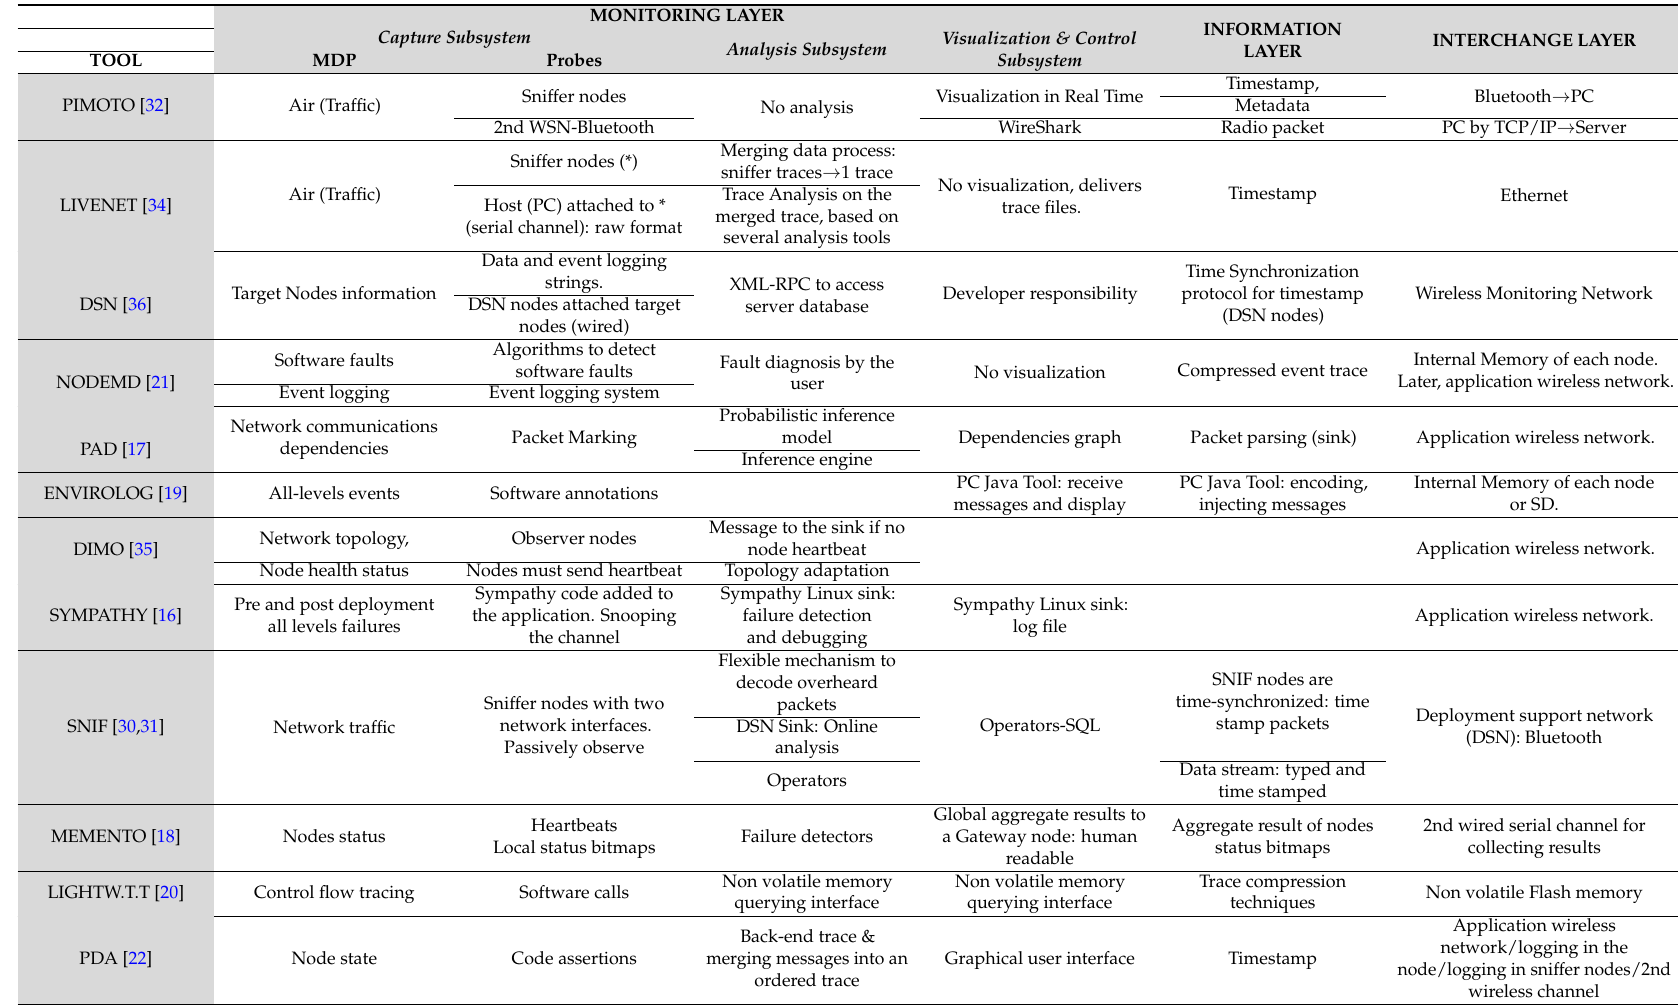
Table 2. Systematic analysis of studied